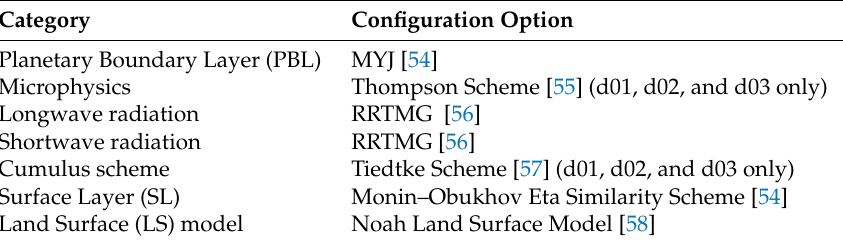
Table 1. WRF configurations and physics